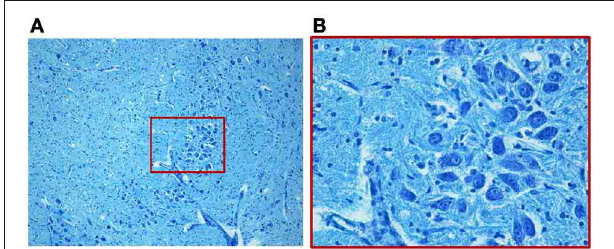
FIGURE 2 | Photomicrograph of the medial superior olivary nucleus (MSO) in a fetus of the control group died at 28 gestational weeks. Panel (B) , the boxed area of (A) at higher magnification, shows a thick group of round immature neurons. Klüver–Barrera stain. Magnification: (A) 10 × ; (B) 40 × .